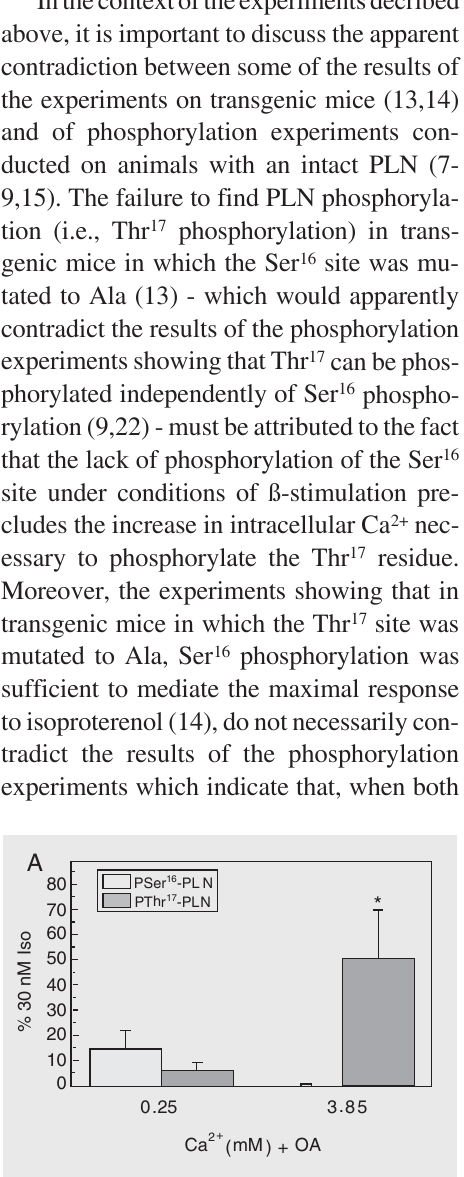
Figure 5. Effects of increasing (Ca 2+ ) o and inhibition of phos- phatases on the phosphoryla- tion of Thr 17 of phospholamban (PLN) and mechanical relax- ation. A , The increase in (Ca 2+ ) o in the presence of okadaic acid (OA) increased the phosphory- lation of Thr 17 site of PLN. B , The increased phosphorylation of the Thr 17 site was associated with a decrease in half relax- 2+ ation time (t 1/2 ). *P < 0.05 com- + OA pared to 0.25 mM Ca 2+ + OA.